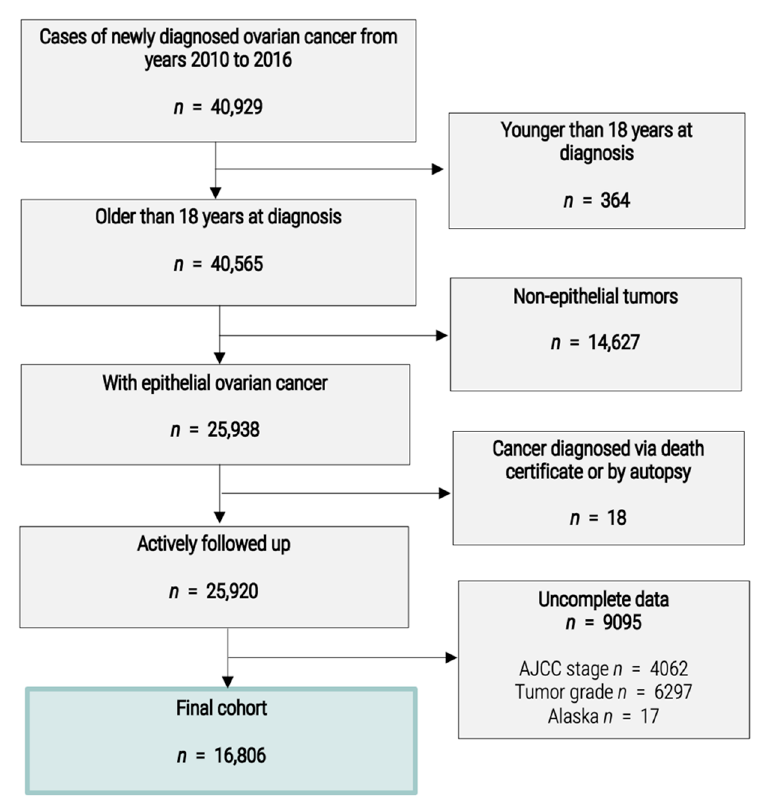
Figure 1. Flowchart. Figure 1.